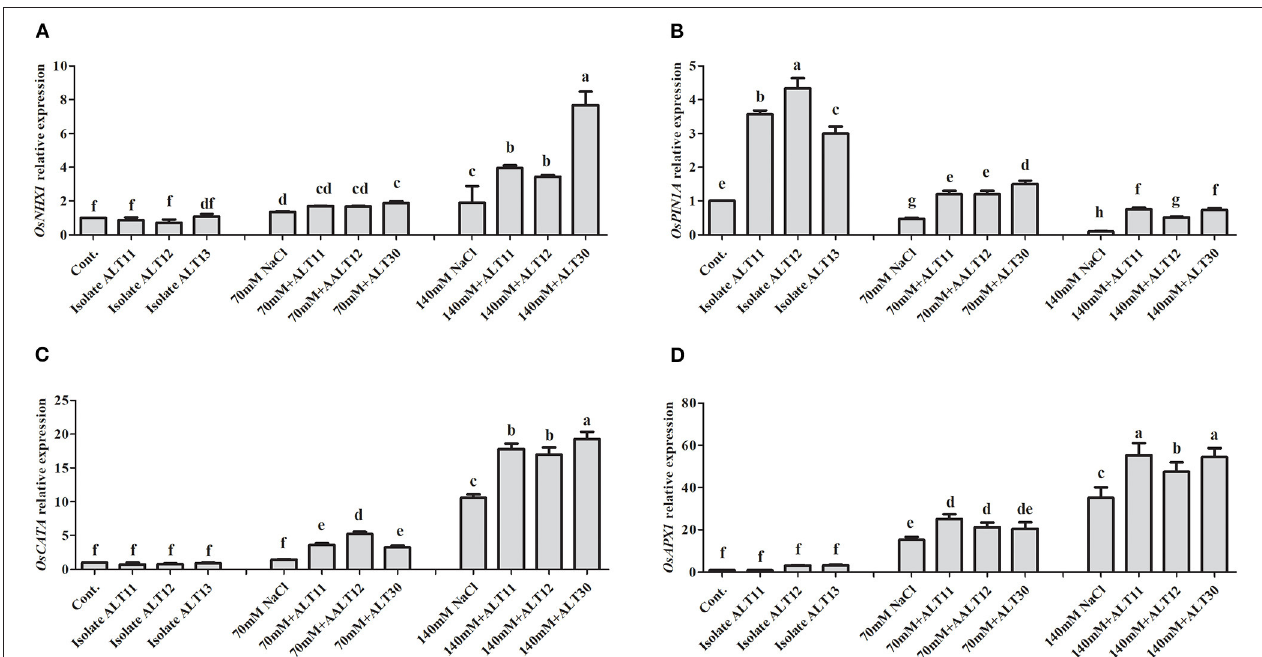
FIGURE 7 | Gene expression in response to ALT11, ALT12, and ALT30 under normal conditions and NaCl stress. Relative expression of (A) OsNHX1 , (B) OsPIN1A , (C) OsCATA , and (D) OsAPX1 genes under normal conditions and NaCl stress (70 and 140mM) calculated using actin gene expression. Different letters indicate significant differences between the mean values of three replicates ± standard